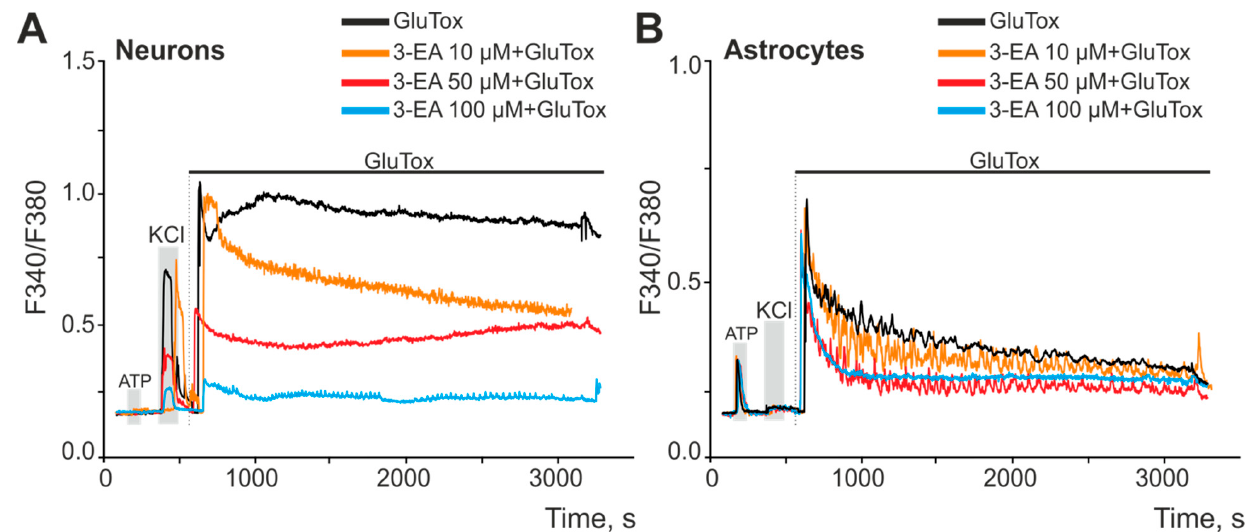
Figure 2. An effect of 24 h preincubation of cortical cells with various concentrations of 3-EA on the increase in [Ca2+]i upon induction of glutamate excitotoxicity for 50 min (GluTox, 100 µM glutamate + 20 µM glycine in Mg 2+ -free medium). ( A , B )—averaged Ca 2+ signals of neurons ( A ) and astrocytes ( B ) of the cerebral cortex during the induction of glutamate excitotoxicity. Short-term (30 s) applications of KCl (35 mM) and ATP (10 µM) were performed to detect neurons and astrocytes, respectively. The experiments were performed in triplicate on three cell cultures of different passages.